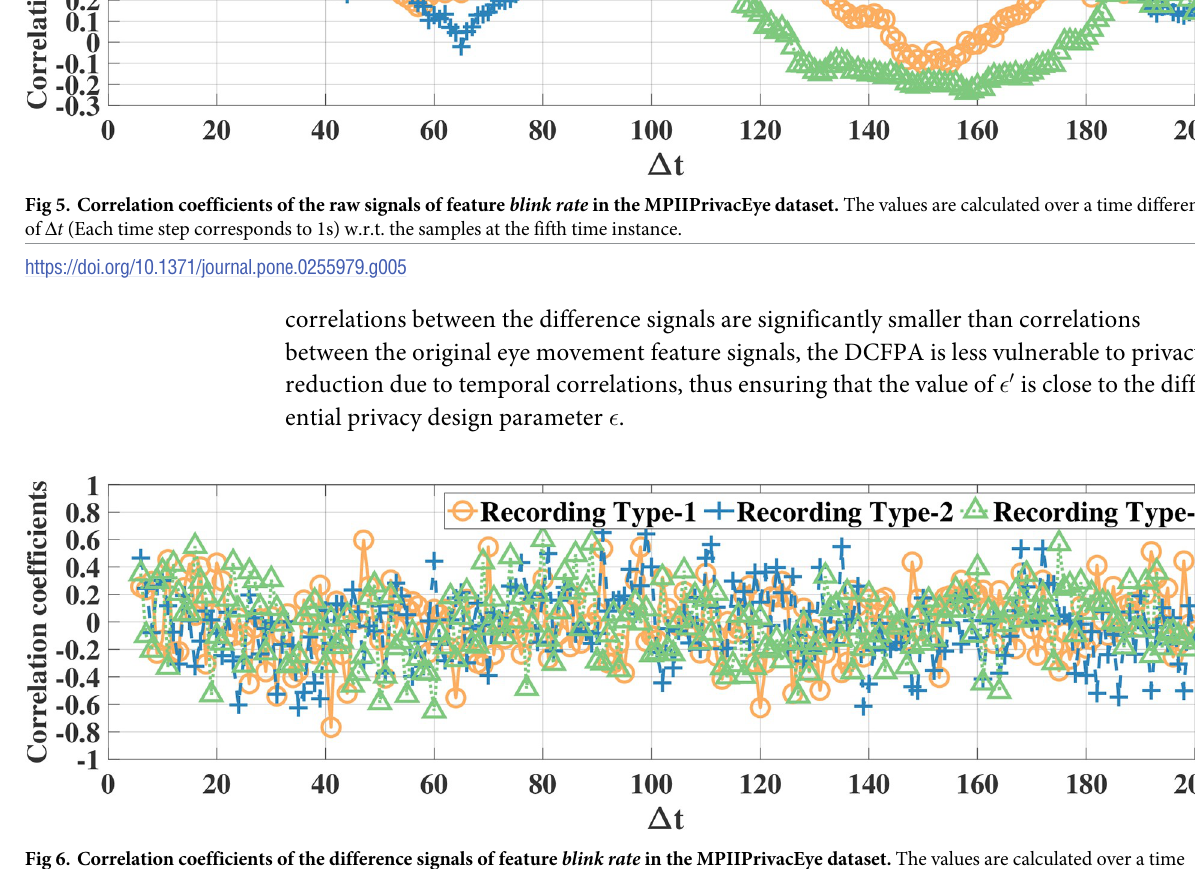
Fig 6. Correlation coefficients of the difference signals of feature blink rate in the MPIIPrivacEye dataset. The values are calculated over a time difference of Δ t (Each time step corresponds to 1s) w.r.t. the samples at the fifth time